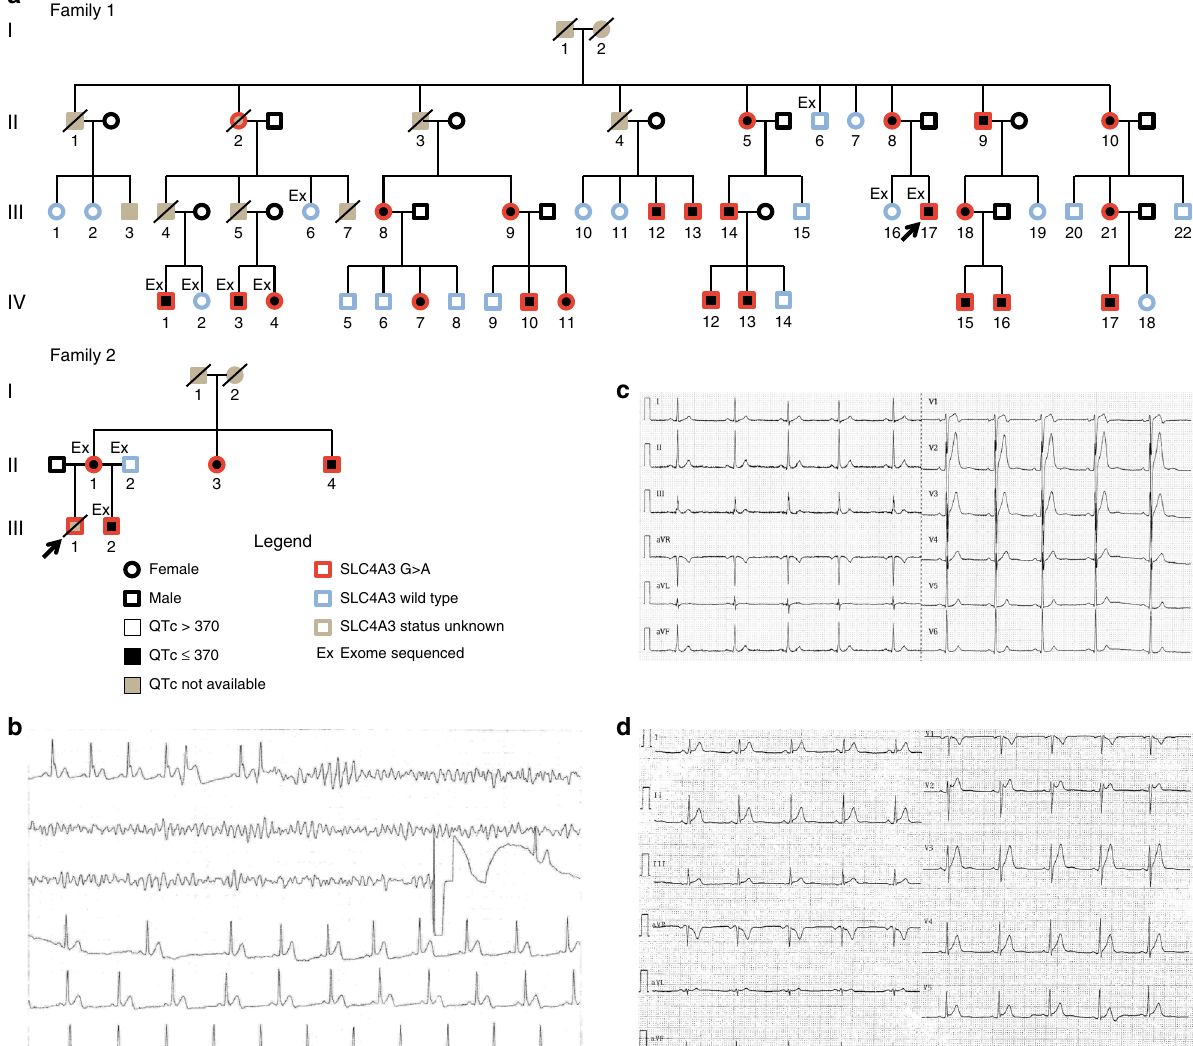
Fig. 1 Pedigrees and representative ECG recordings in two families with SQTS. a Pedigree of family 1 and 2. Proband marked with an arrow. b ECG recording showing ventricular fi brillation and DC shock conversion to sinus rhythm in the proband in family 1. c ECG-12 from the proband in family 1. d ECG-12 from patient III-2 in family